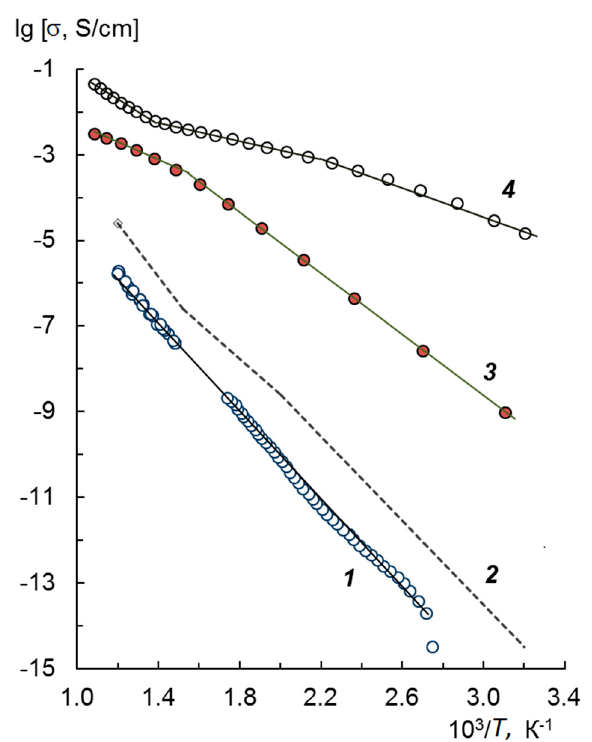
Figure 8. Comparative data on the ionic conductivity temperature dependencies σ ( T ) of the ScF 3 single crystal [this work and 33] ( 1 ), polycrystalline ScF 3 [56] ( 2 ), HoF 3 [63] ( 3 ) and LaF 3 [65] ( 4 ) single crystals.